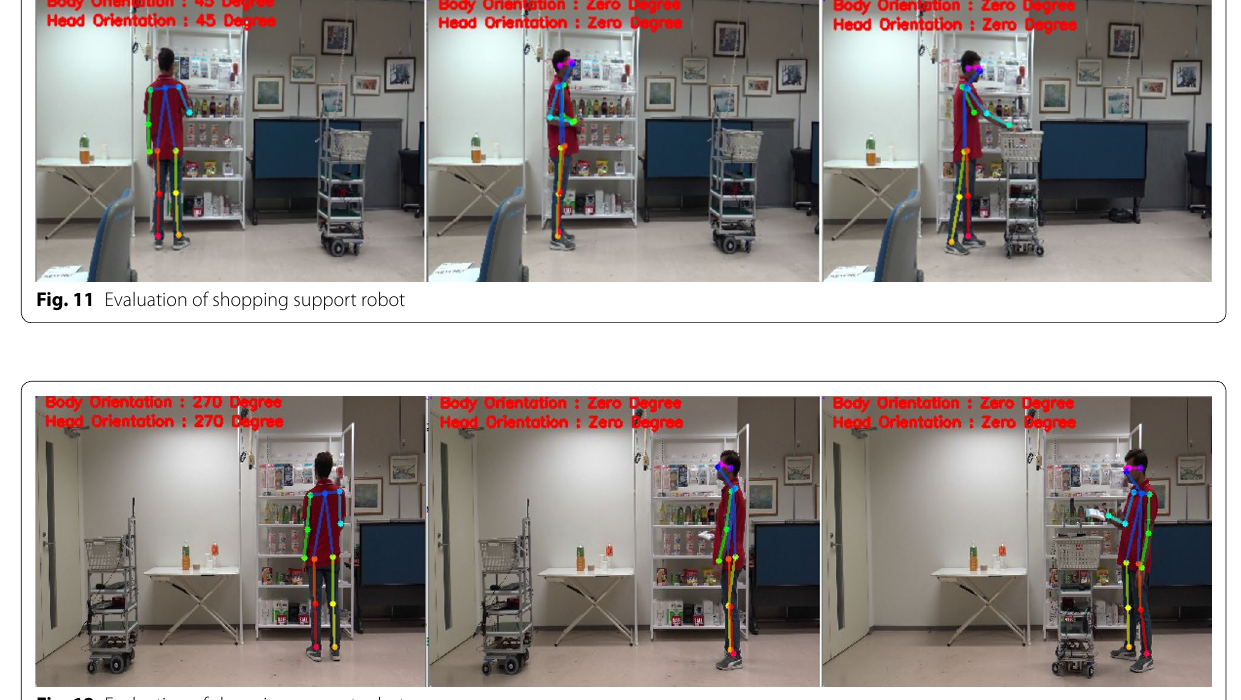
Fig. 12 Evaluation of shopping support